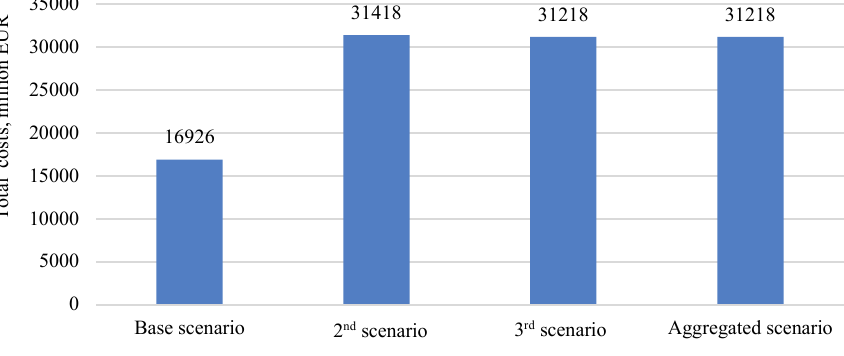
Fig. 10. Total costs of FBVM scenarios, thousand